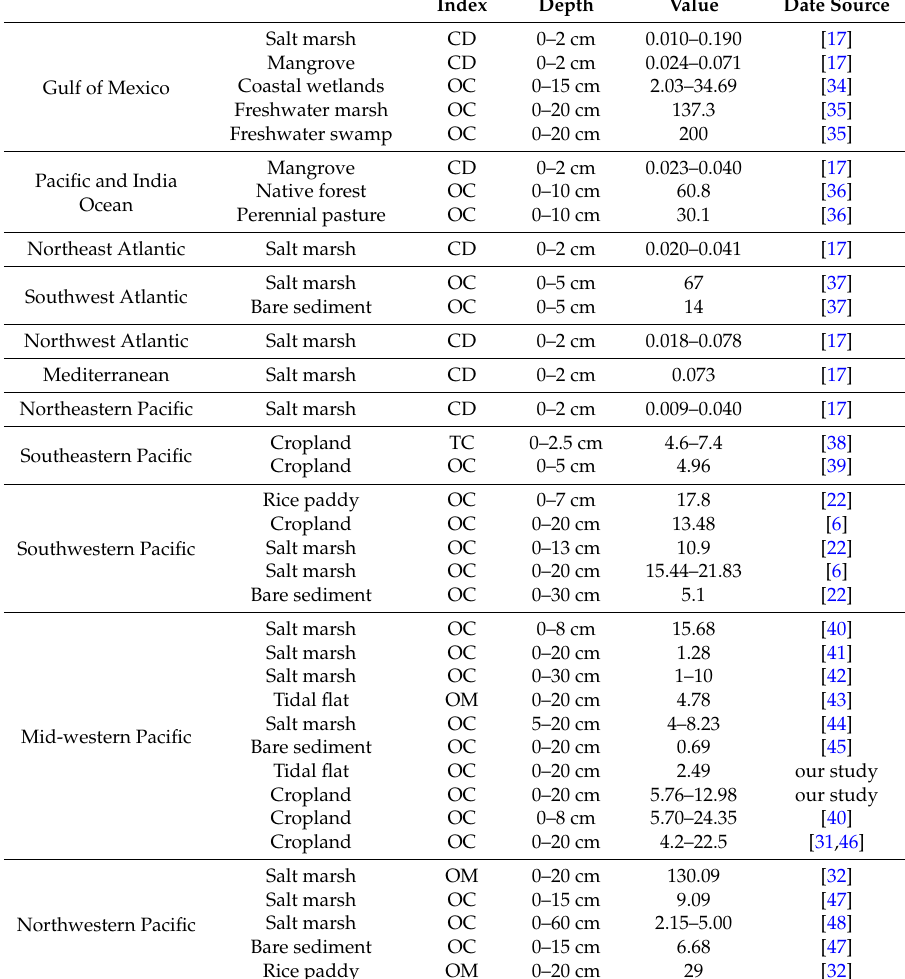
Table 5. SOC of salt marshes at different coastal tidal flats in the